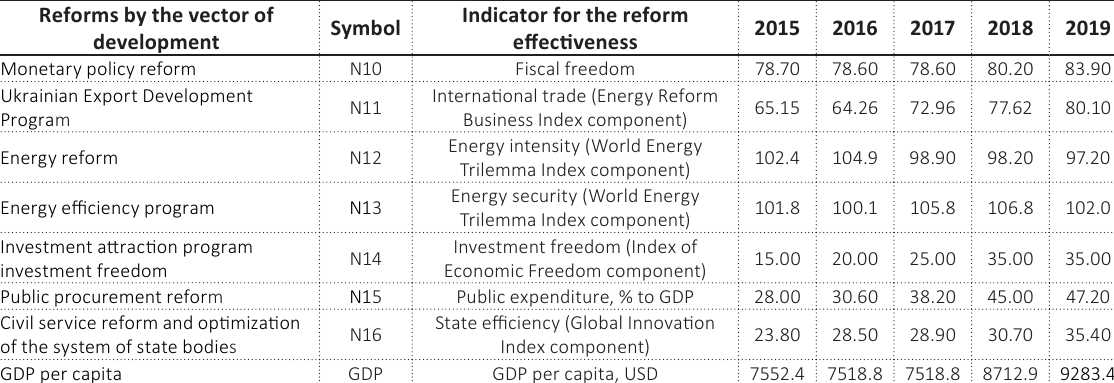
Table 2 (cont.). The value of international indices as an indicator of assessing the implementation of reforms and programs of sustainable economic development of Ukraine in 2015–2019